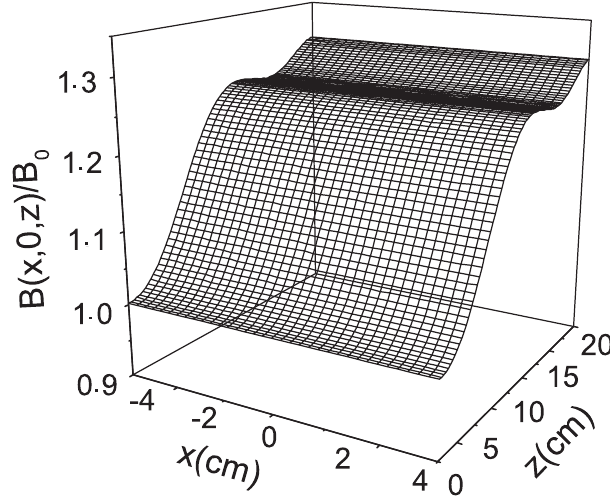
FIG. 4. The magnetic field profile in the y ¼ 0